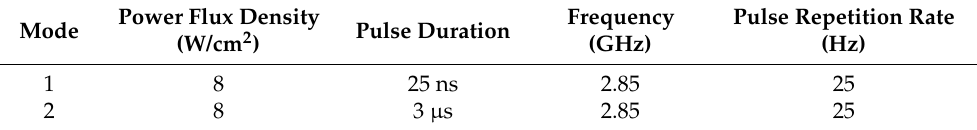
Table 1. Experimental